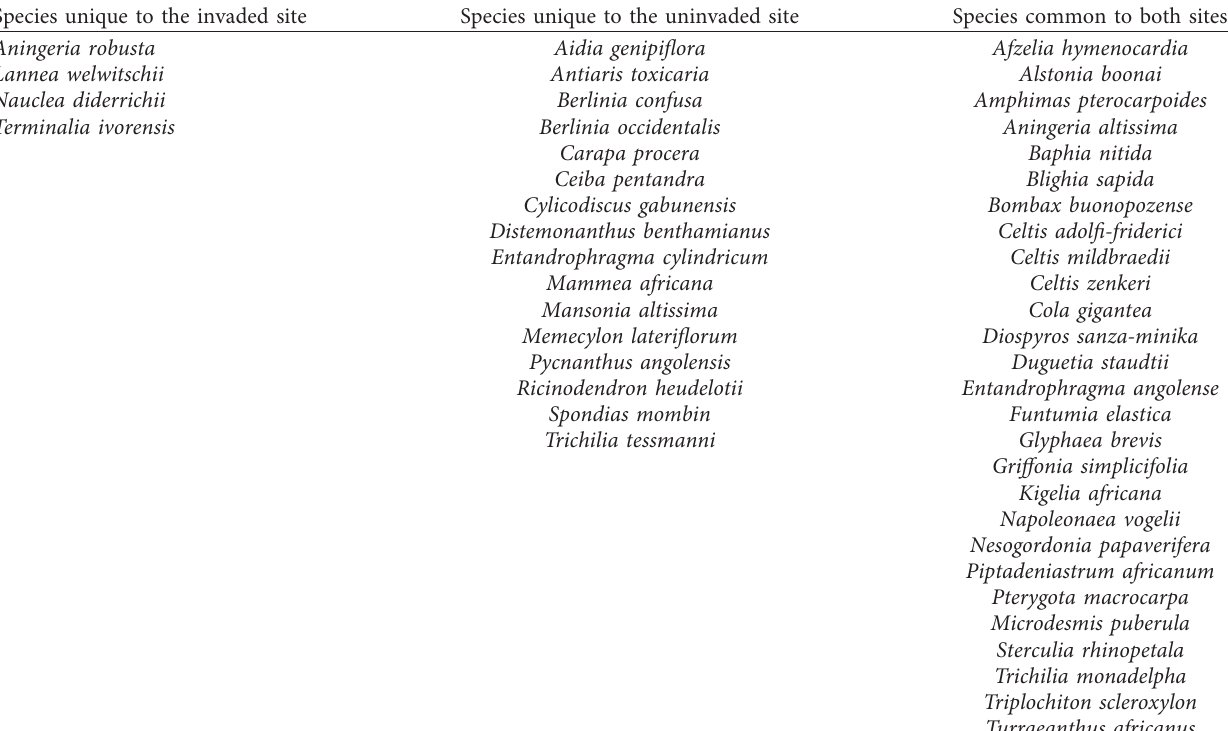
Table 1: Species distribution on the study